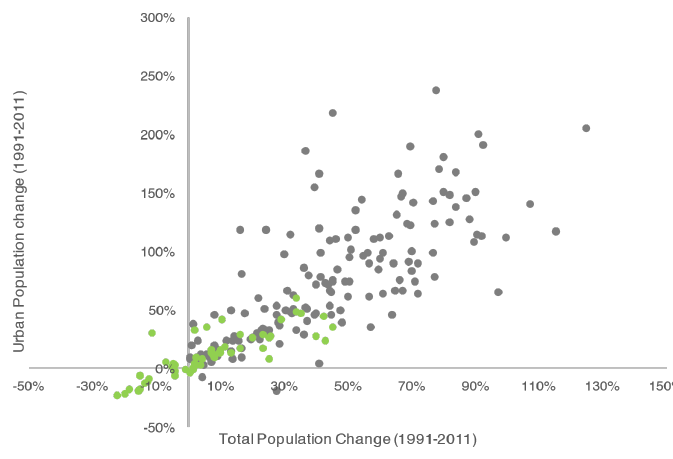
Figure 1: Urban and total population growth, ECA (green) countries versus